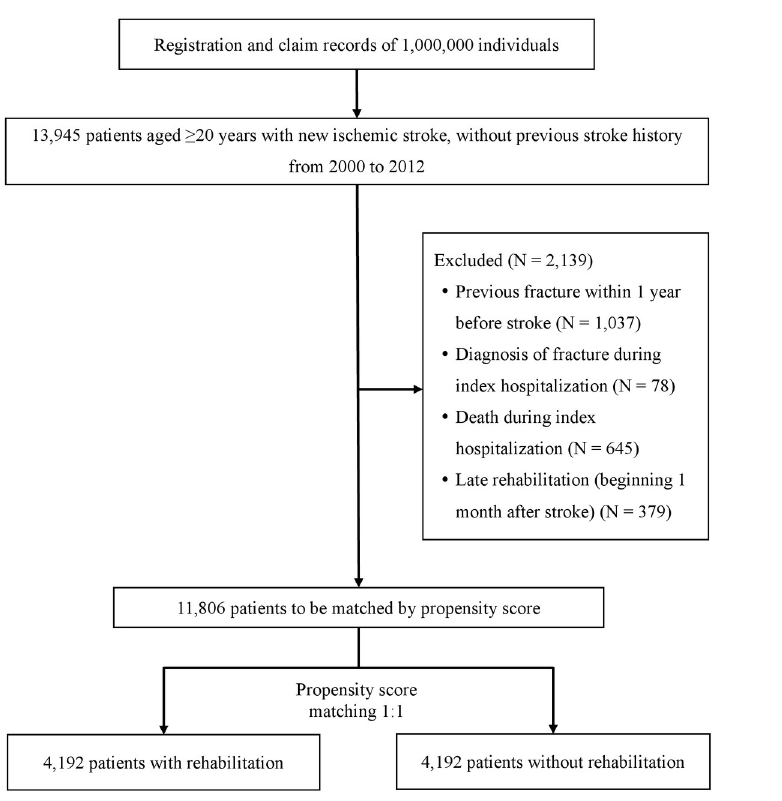
Fig 1. Flow diagram of selection of study